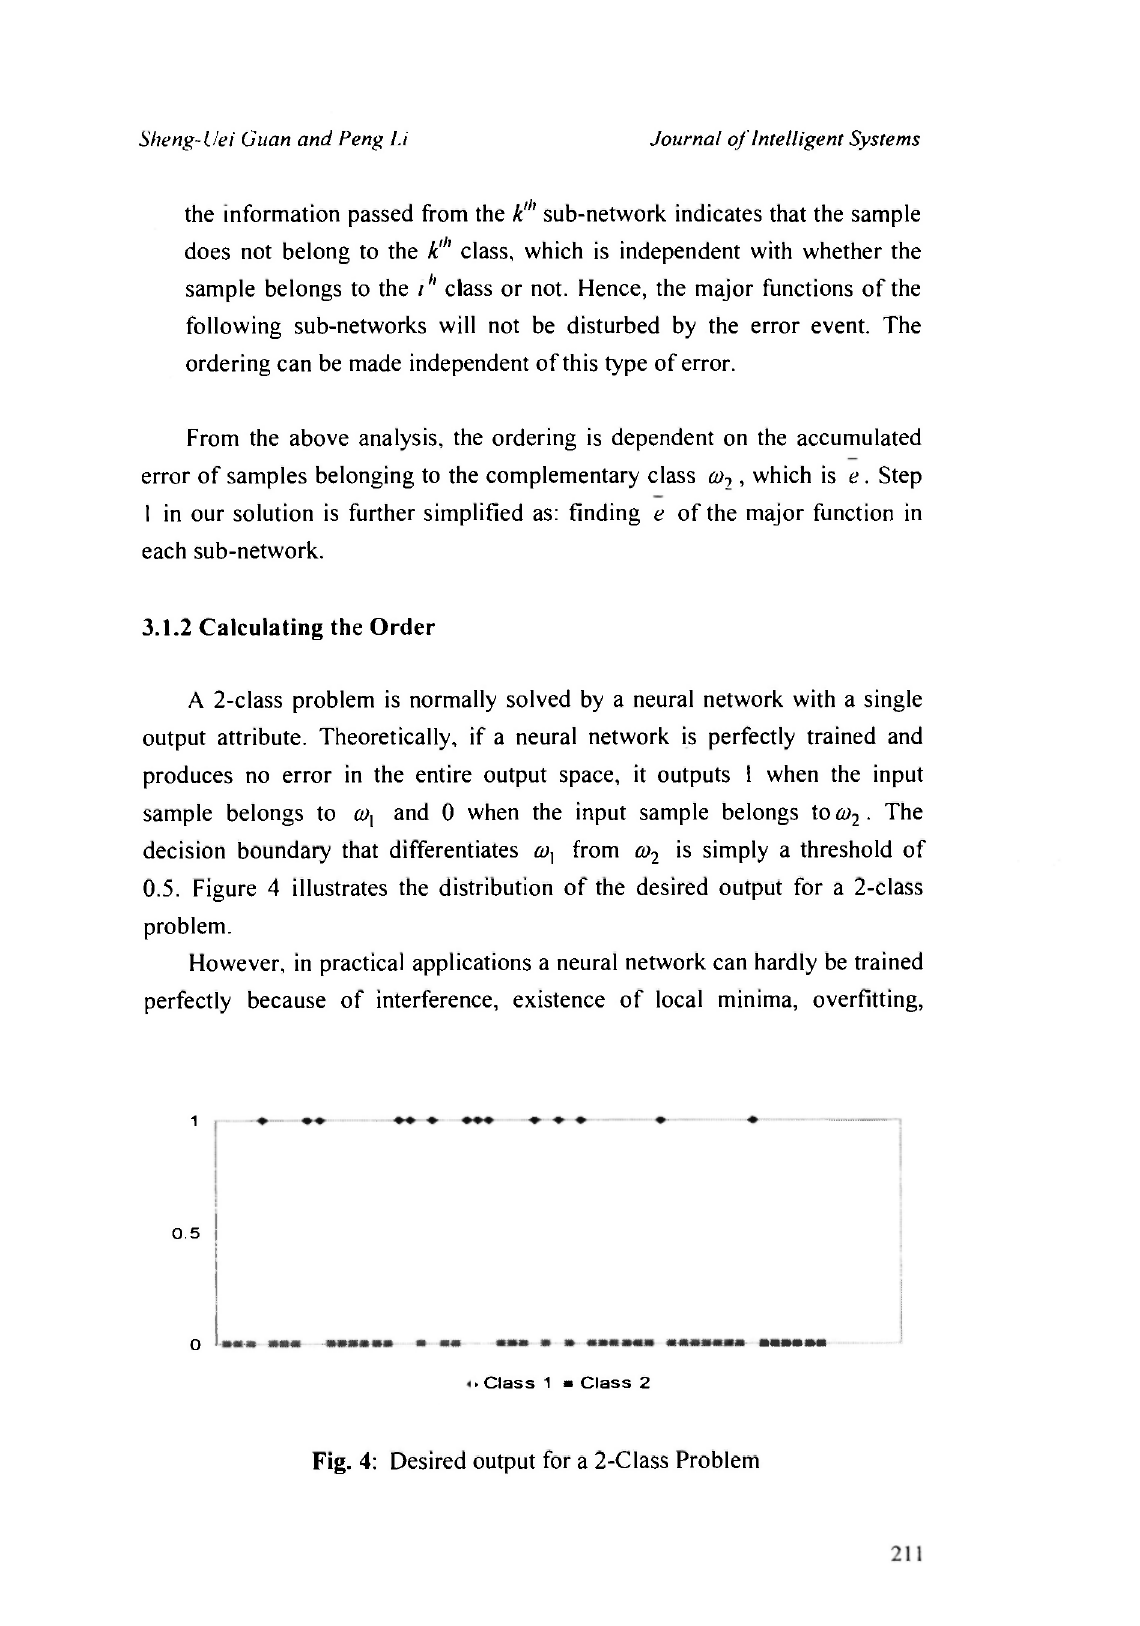
Fig. 4: Desired output for a 2-Class